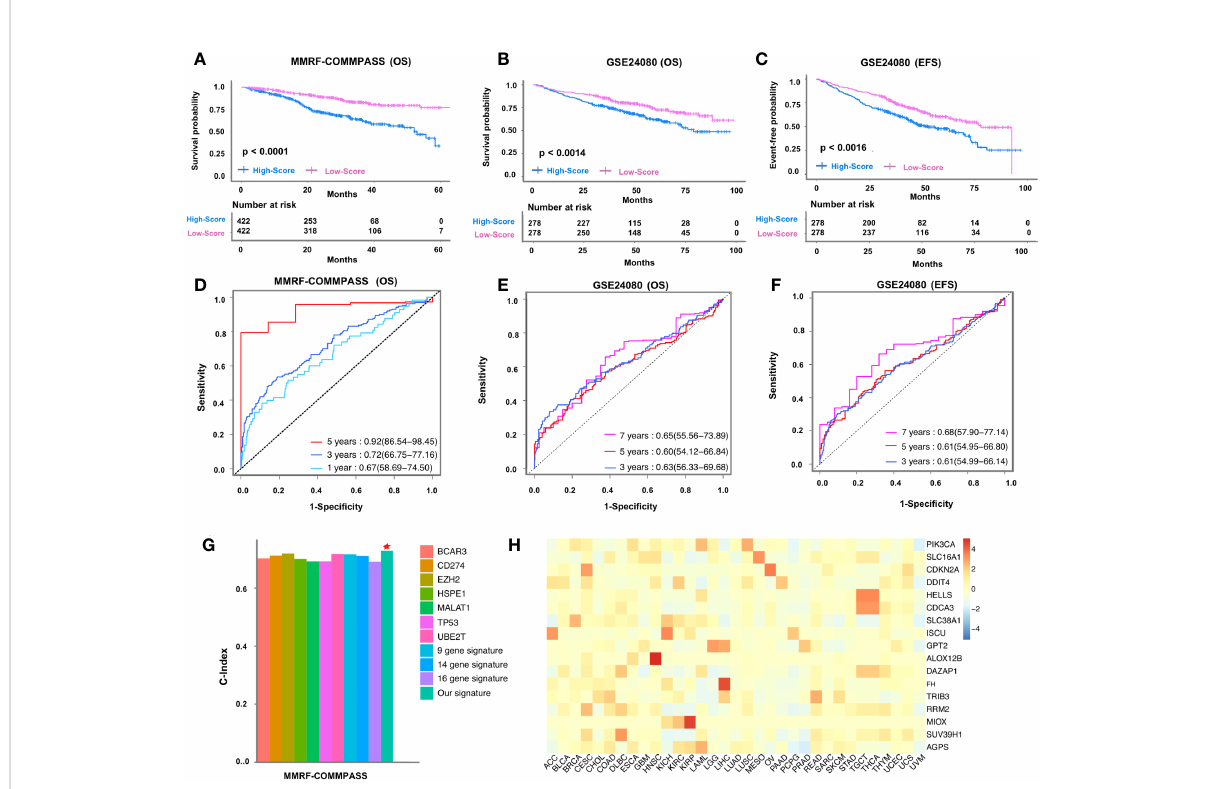
FIGURE 1 Clinical application of 14-gene signature in MMRF-COMMPASS and GSE24080 cohorts. Kaplan-Meier curves of the 14-gene signature risk score in the training cohort (A) and validation cohort (B, C) . ROC curves of the 14-gene signature risk score in the training (D) and validation (E, F) cohorts. Comparison of the C-indexes between the ferroptosis-related fourteen-gene signature and other existing biomarkers in multiple myeloma (G) . The risk coef fi cient between 14 genes and 33 types of cancer (H) . Red star represented our ferroptosis-related fourteen-gene